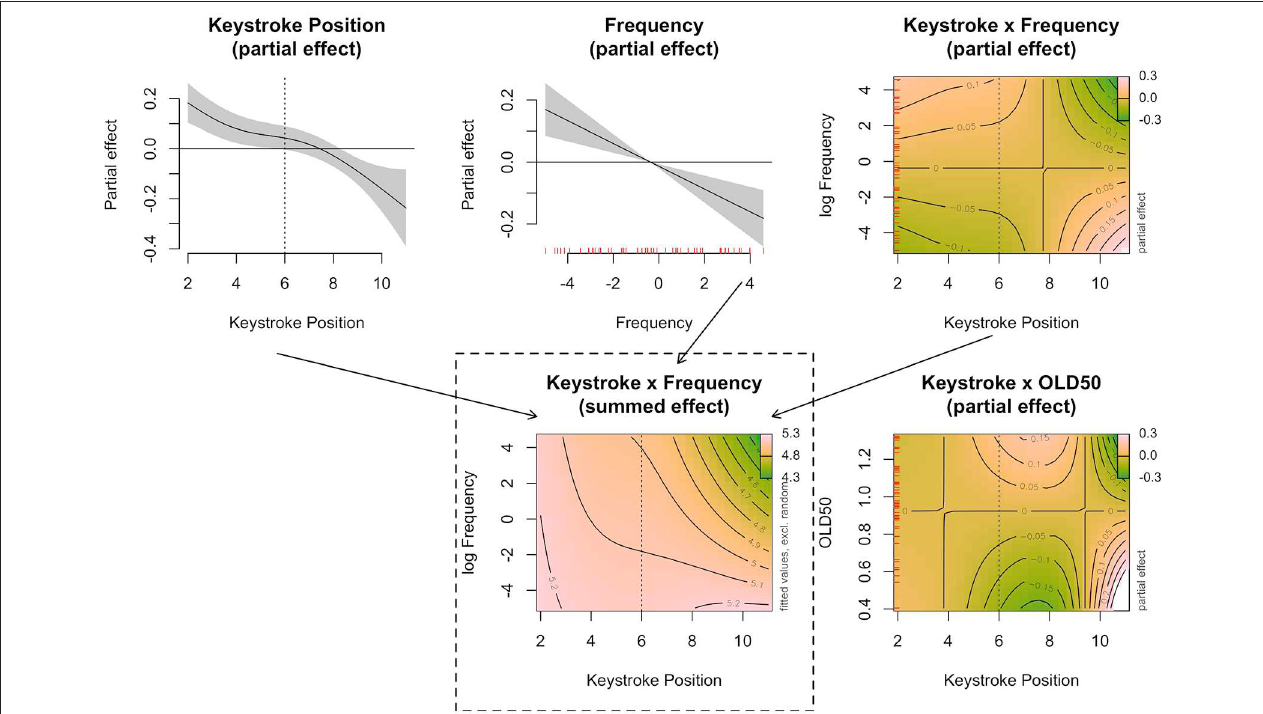
FIGURE 9 | Estimates from the best-fitting statistical models of the keystroke trajectories (excluding the first keystrokes of the words) aligned to the onset of the stem for the Suffix words in Experiments 2, and 3. The top row shows the partial effects of Keystroke Position (left) , Frequency (center) , and Keystroke Position by Frequency (right) . The bottom row shows the partial effect of Keystroke Position by OLD50 (right) and the summed effects of Keystroke Position by Frequency, with random effects excluded (center)